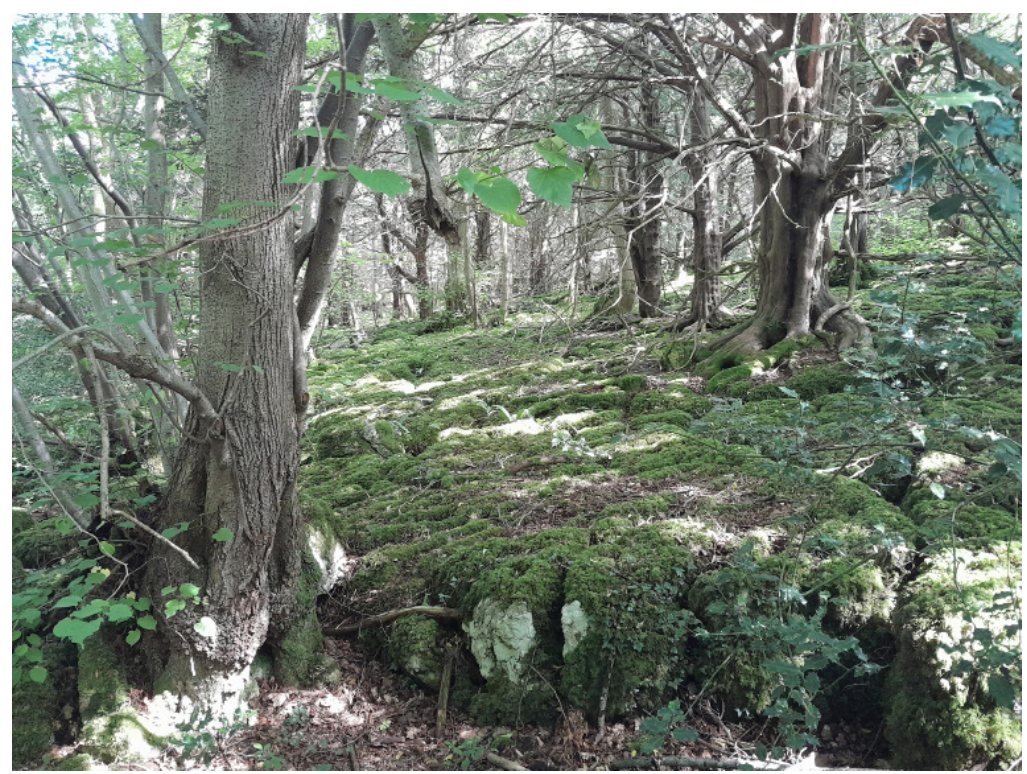
Figure 2. A typical vegetated limestone pavement on dipping strata from the Morecambe Bay region of Northwest